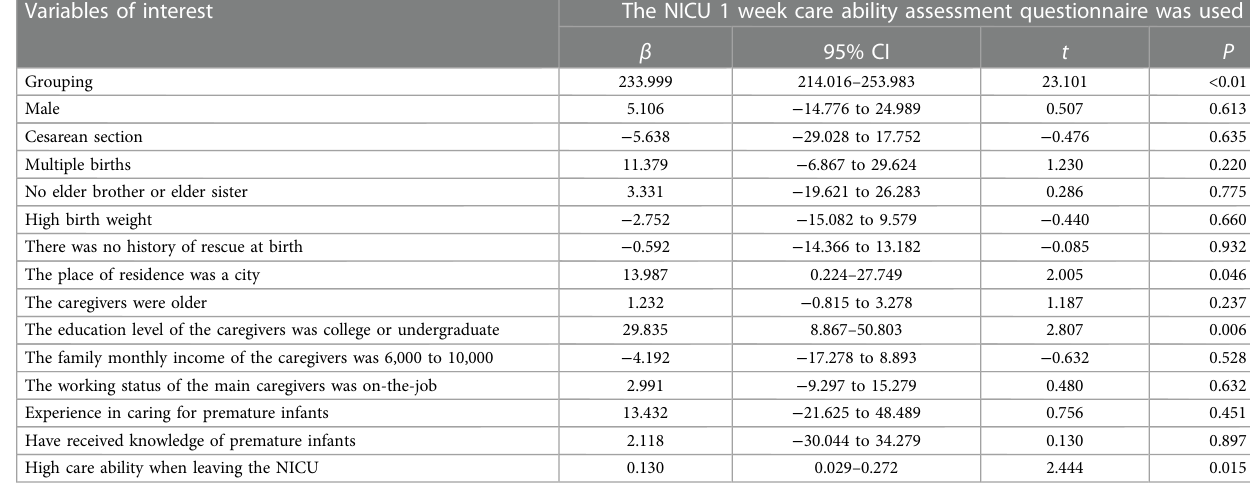
TABLE 8 Results of linear regression analysis of care ability of primary caregivers of premature infants at 1 week after NICU. Variables of interest